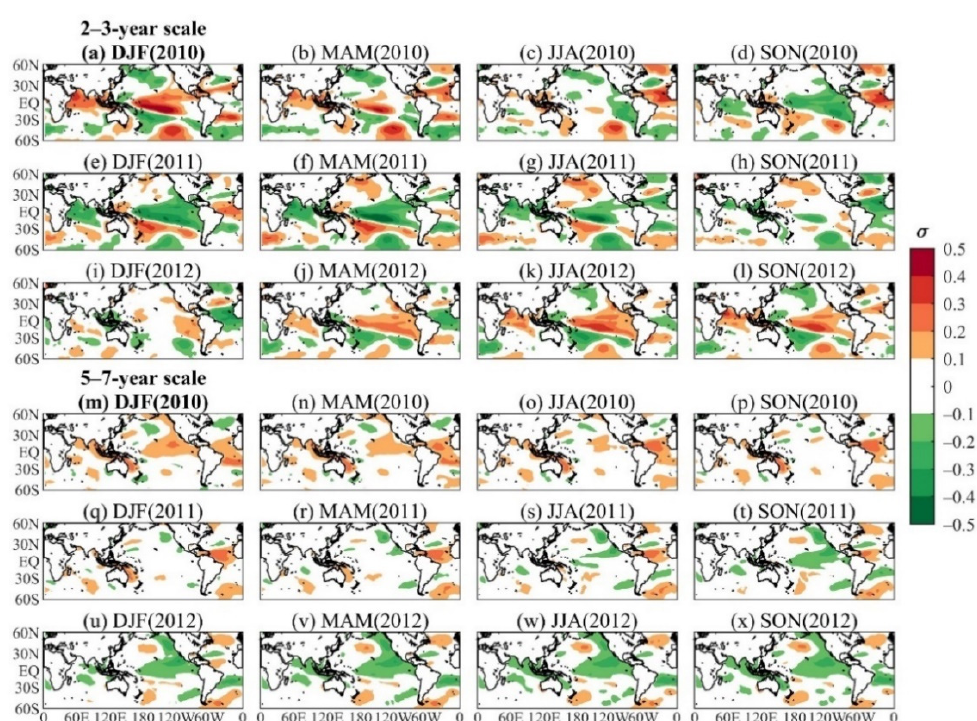
Figure 10. Seasonal sea surface temperature anomalies filtered at ( a – l ) biannual 2–3-year and ( m – x ) interannual 5–7-year scales between DJF 2010 and SON 2012.